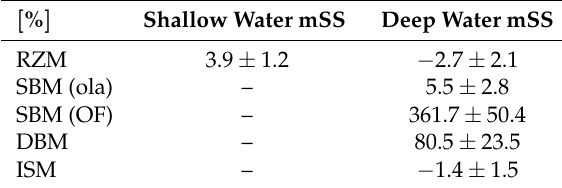
σ (cid:101) for the evaluation of the absorption quality at the wave generation boundary. Table 14. Error (cid:101) ¯ H msw ± ¯ Hmsw